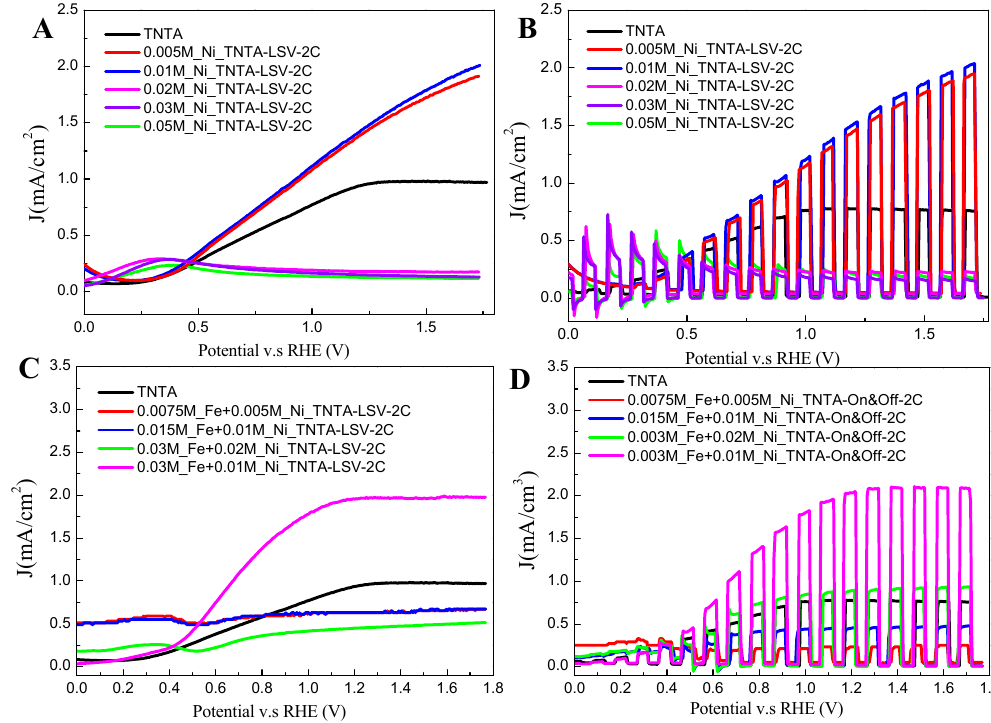
Figure 5. ( A ) Linear sweep voltammetry (LSV) curves of optimization for Ni-TNTA at a scan rate of 10 mV; ( B ) The chopped light chronoamperometric measurements of optimization for Ni-TNTA at a scan rate of 10 mV; ( C ) LSV curves of optimization for FeNi-MOF / TNTA at a scan rate of 10 mV; ( D ) The chopped light chronoamperometric measurements of optimization for Fe / Ni-TNTA at a scan rate of 10 mV.